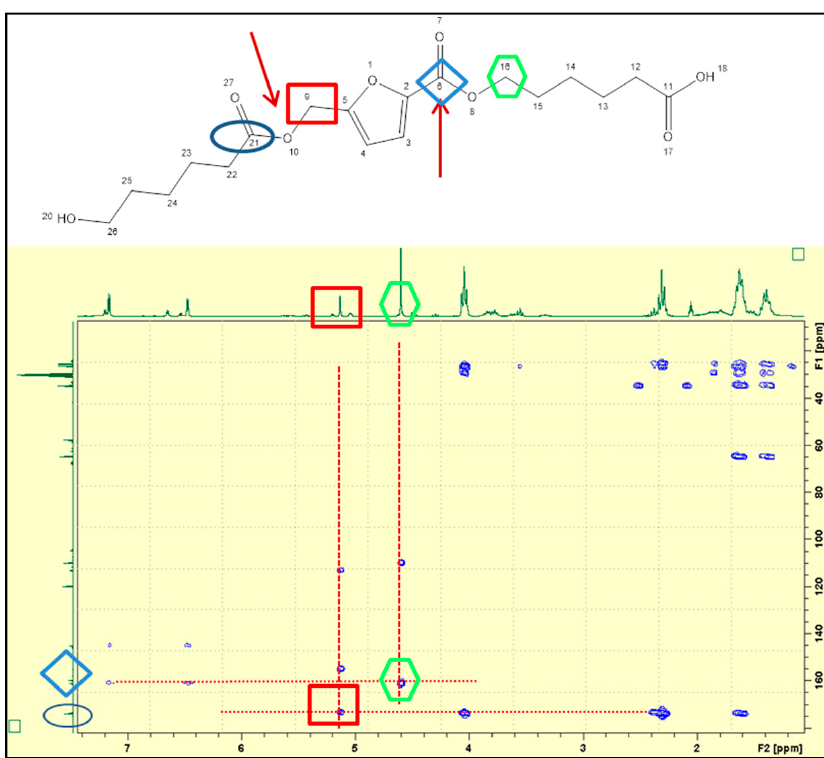
Figure 3. The two-dimensional 2D HMBC NMR spectra of the HMFA_ECL reaction product obtained at 80 °C, 24 h reaction time, mixing frequency 1000 min − 1 . The oligomer showed above to illustrate the spectrum is formed by two structural units derived from ε -caprolactone and one from 5-hydroxymethyl-2-furancarboxylic acid.